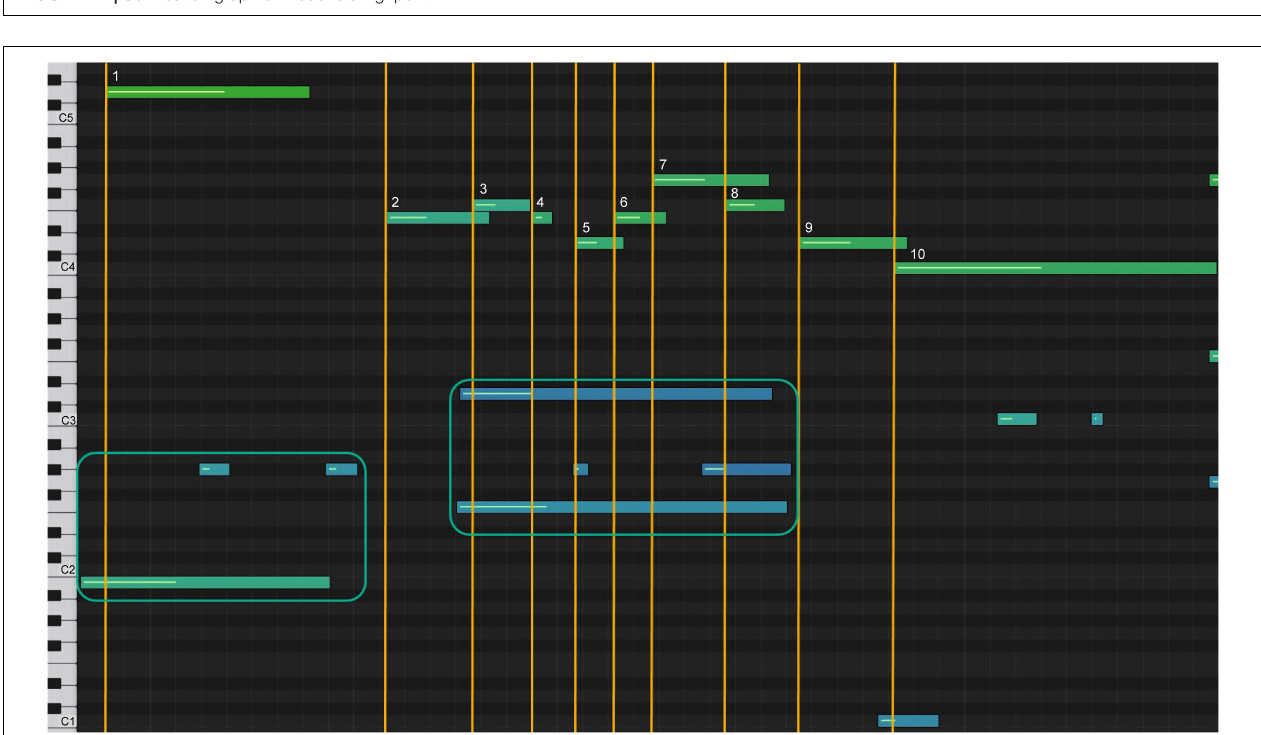
FIGURE 13 | Sonification graph of student’s highpoint after analysis.